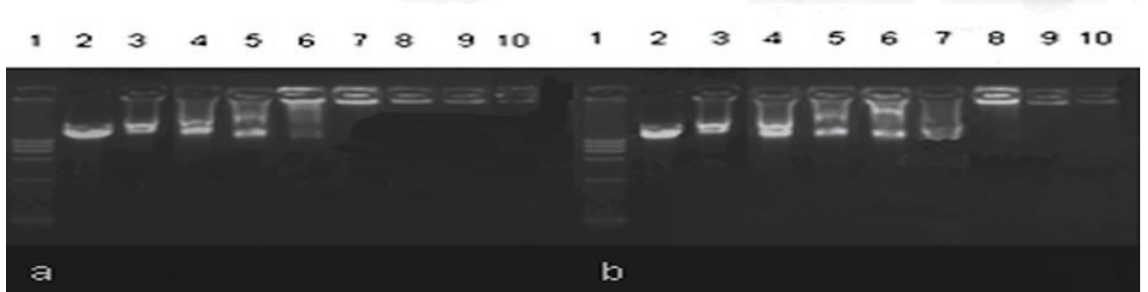
Figure 4. Agarose gel retardation assay. Lane 1 is molecular weight Marker. Lane 2 is DNA only. Lines 3 to10 correspond to polymer/DNA complexes in PBS at different N/P ratios of 0.1, 0.2, 0.5, 1.0, 1.5, 2, 3, and 5. P30 (a), P60